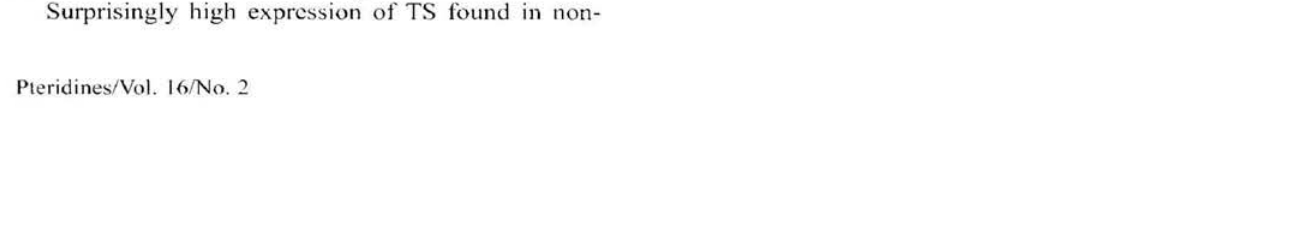
Figure. TS ligands potcntiatc (lancs 4,5) Inhibition by TT spiralis TS (lane 3) of in vitro translation of its own mRNA (lane 2; control reaction without mRNA in lanc